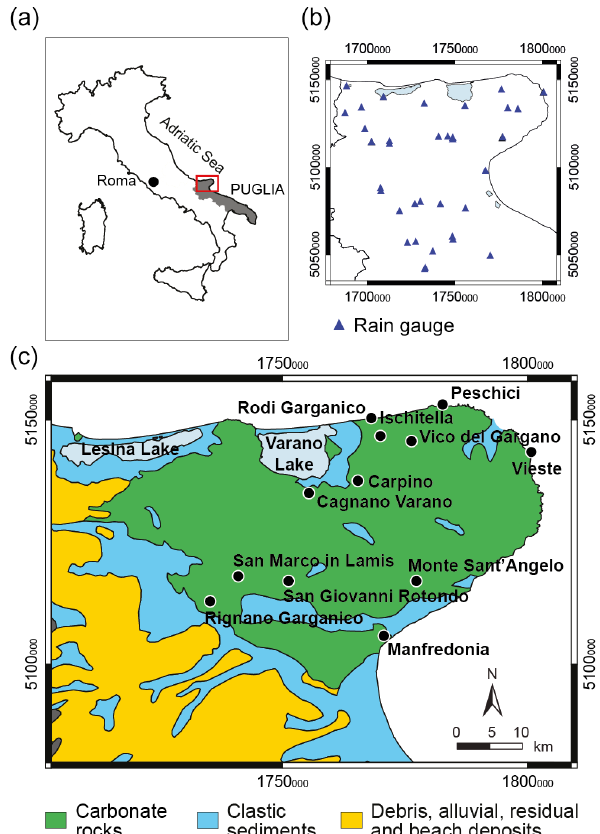
Figure 1. Panel (a) shows the location of the study area (red rectan- gle) in Italy. Grey area is the Puglia (Apulia) region. Panel (b) shows the location of 39 rain gauges in the study area and the neighbour- ing area. Panel (c) shows the main rock types (colours) and place names in the study area. WGS84/Pseudo Mercator (EPSG: